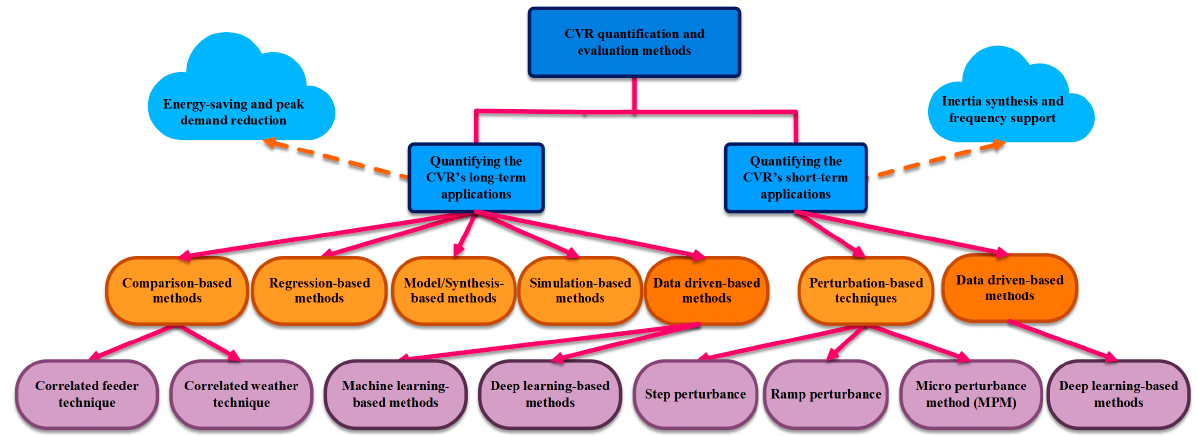
Figure 13. The overall perspective of CVR quantification methods.